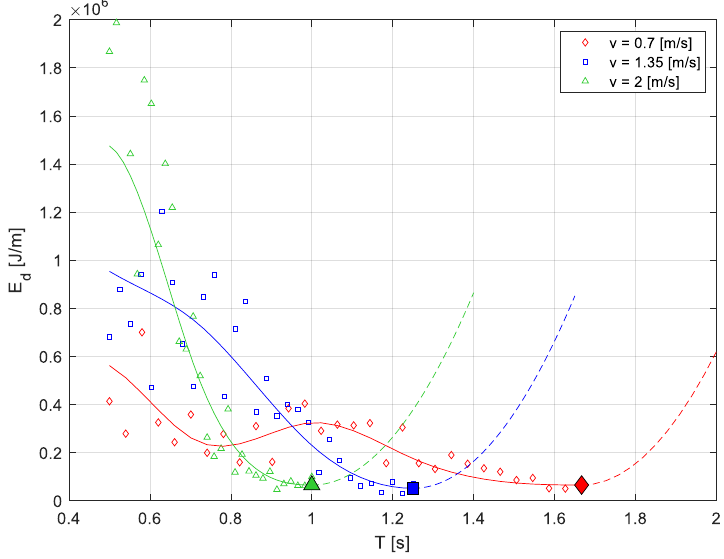
Figure 17. Trot gait energy 𝐸 𝑑 for different speeds and time cycles T.